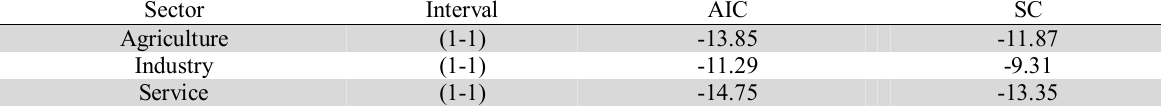
The summary of Akaike Information Criterion and Schwarz Information Criterion